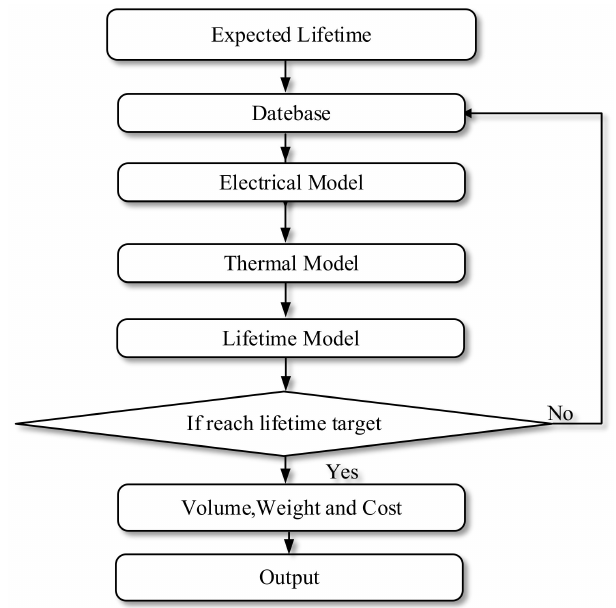
Figure 3. Flowchart of the reliability-oriented design procedure for the performance comparison of passive magnetic inductor and variable active